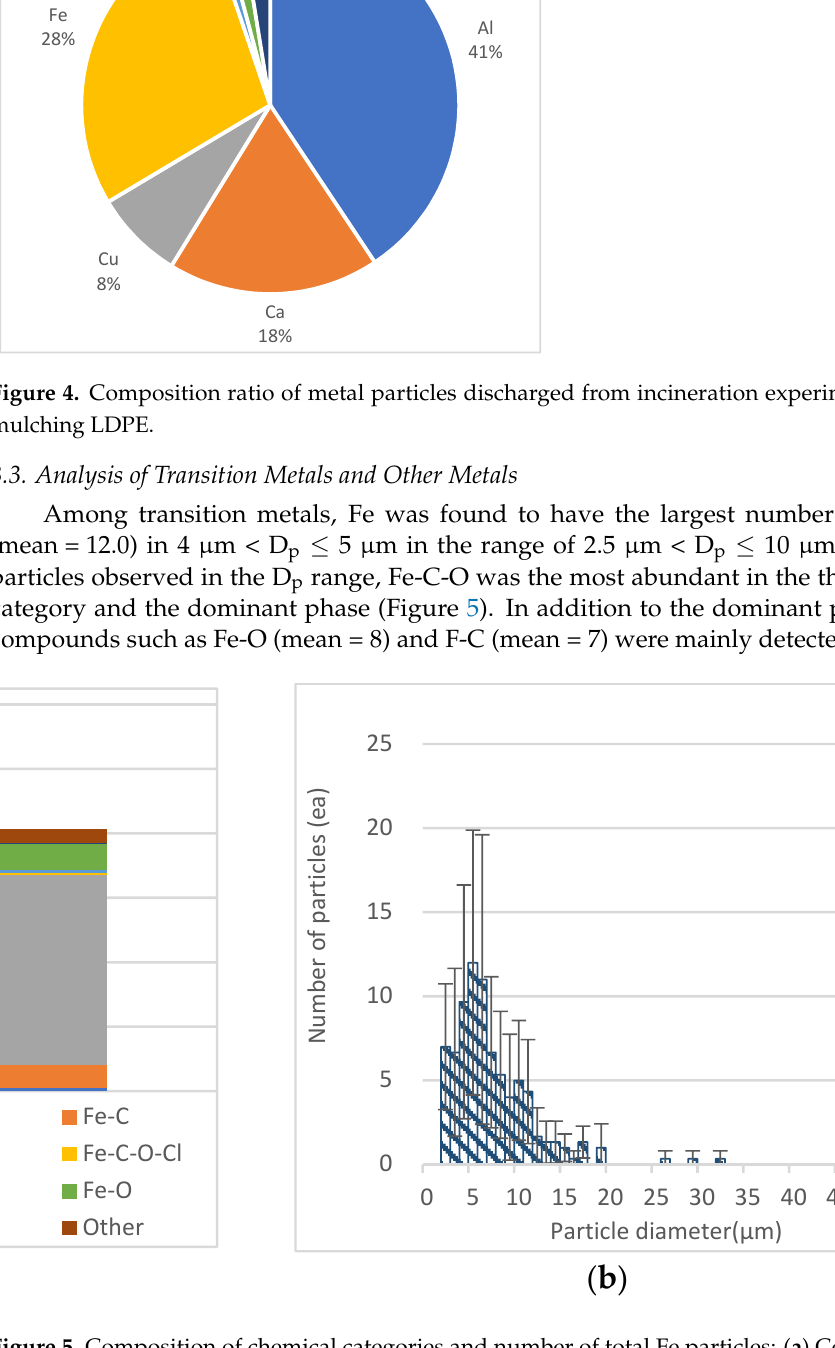
Figure 4. Composition ratio of metal particles discharged from incineration experiment of waste mulching LDPE.